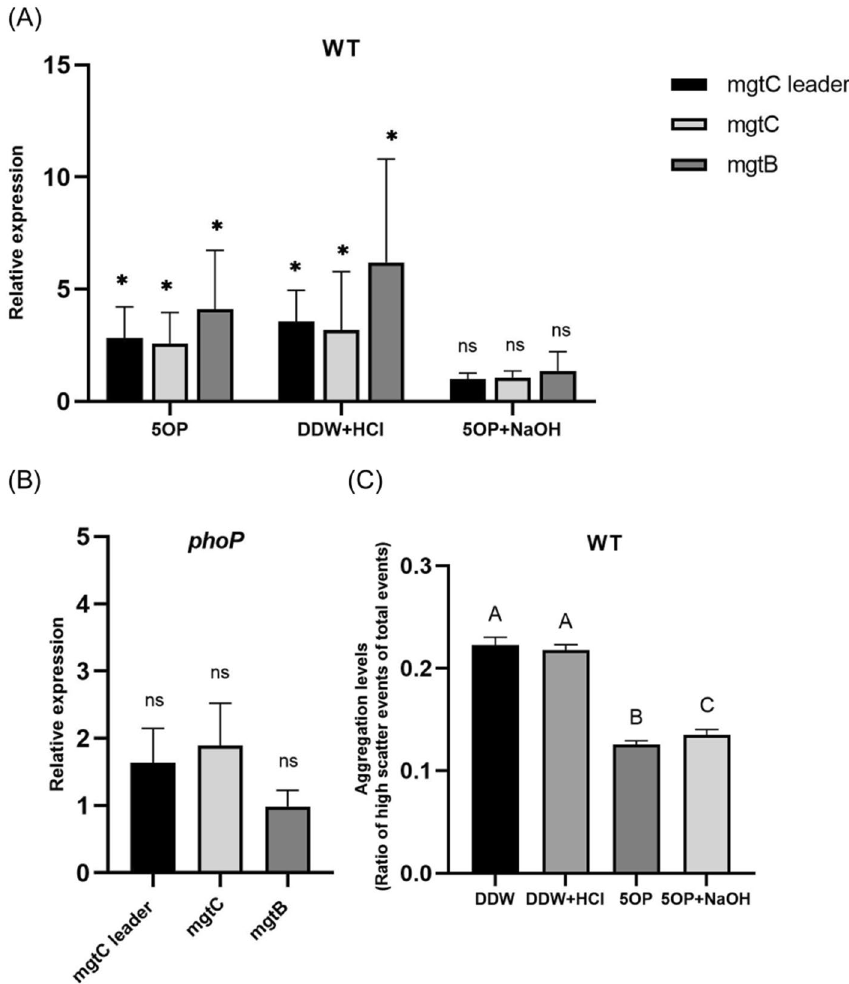
Figure 5. pH and PhoPQ regulate mgtCBR expression but not cellular aggregation. ( A ) Analysis of mgtCBR levels in wild-type salmonella exposed for 2 h to 5OP, DDW, 5OP and NaOH to restore pH (5OP + NaOH), or to DDW while pH was reduced by adding HCl (DDW + HCl). **P < 0.01, *P < 0.05, ns = not significant. ( B ) Analysis of mgtCBR levels in a phoP knockout mutant strain, exposed to 5OP or DDW. All panels represent the average of three independent experiments. One-Way ANOVA for each treatment vs. DDW control ( A ) and T-Test were conducted ( B ). ns = not significant. Geometric mean and standard error of mean are shown. ( C ) Cellular aggregation ratio of Salmonella wild-type exposed to 5OP, DDW, 5OP and pH restored by adding NaOH (5OP + NaOH), or to DDW while pH was reduced by adding HCl (DDW + HCl). Due to variation between experiments a representative experiment out of three is shown. One-Way ANOVA was conducted between treatments ( C ). Treatments denoted by different letters are statistically different at a P value of 0.0001 or less. Standard deviation is